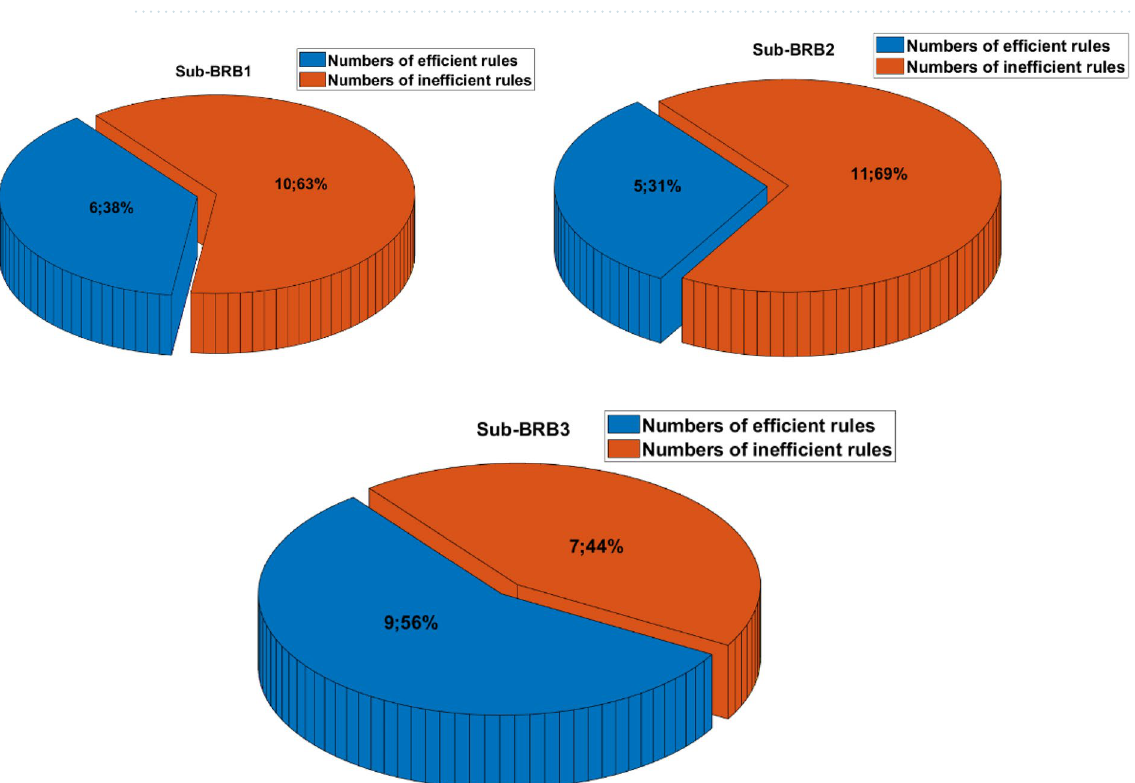
Figure 25. Comparison of the number of effective rules of the DBRB-I(20)